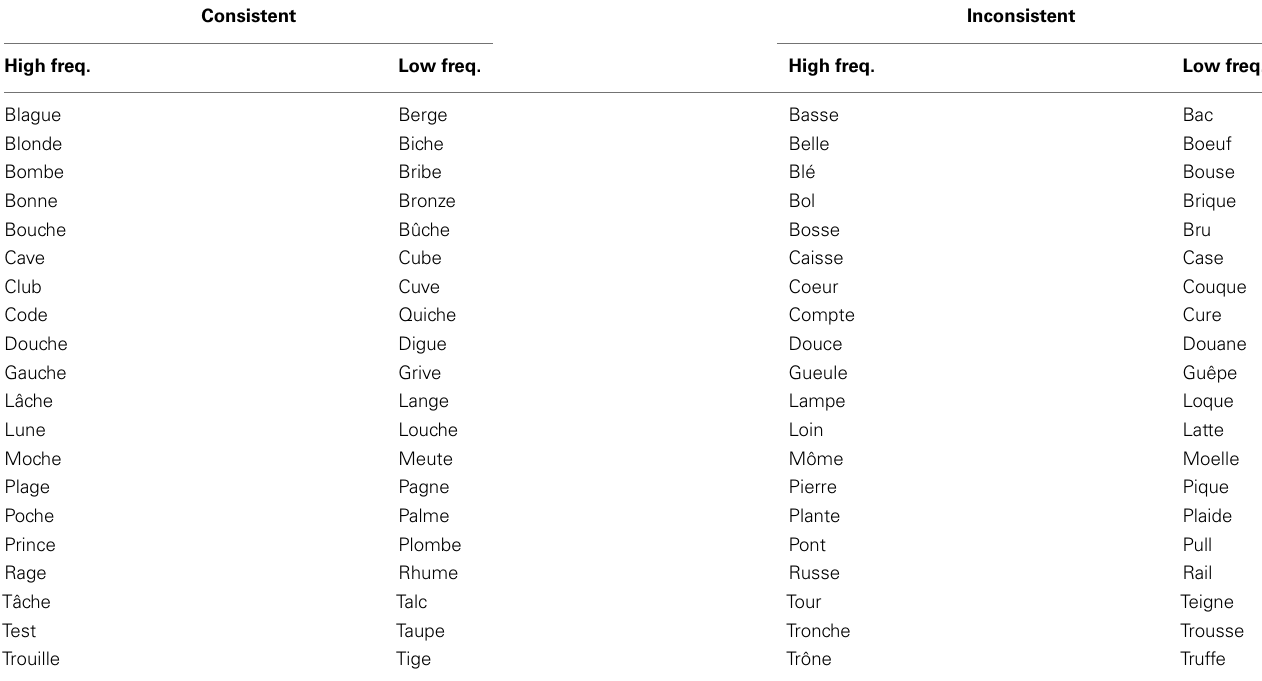
TableA1 |Word stimuli.